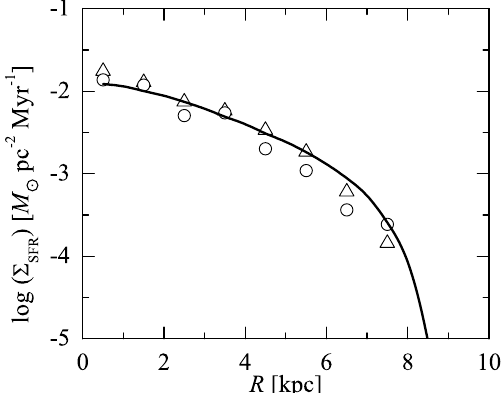
Fig. 4. Star formation rate (SFR) density profiles. The solid line denotes the average of 30 models; the triangles and circles represent data derived from observations (Verley et al. 2009) using different tracers (FUV and H (cid:11) respectively).